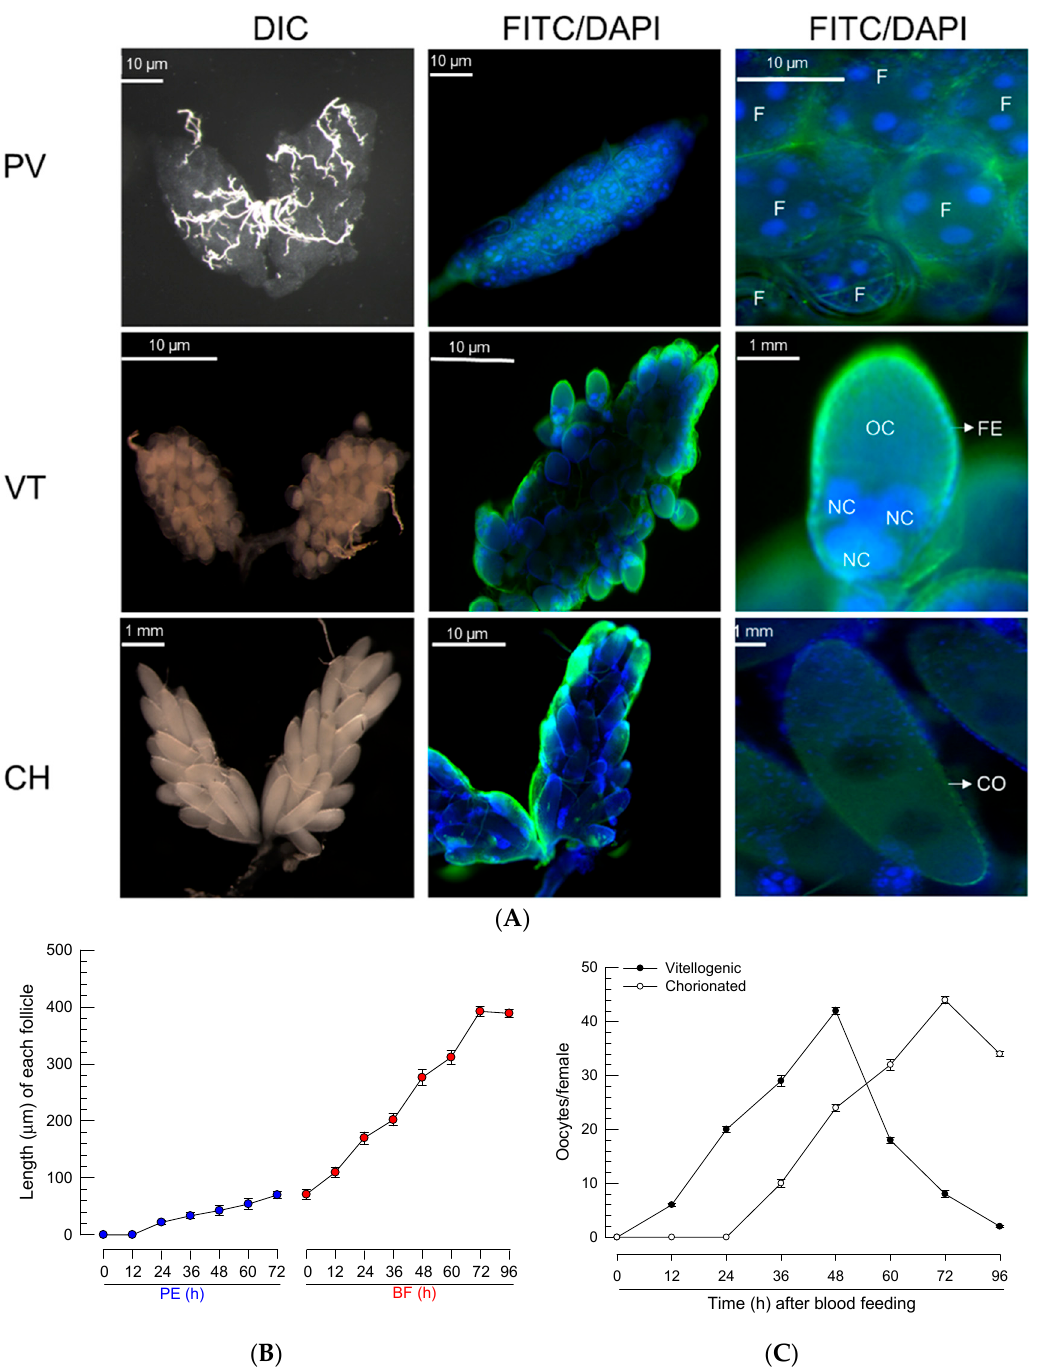
Figure 1. Oocyte development of Ae. albopictus females. ( A ) Three developmental stages of oocytes: previtellogenic (‘PV’), vitellogenic (‘VT’), and chorionated (‘CH’). Ovaries were observed at differ- ential interference contrasts (‘DIC’). Their cells were stained with FITC-tagged phalloidin (green) and DAPI (blue). Follicles (‘F’) were visible at the PV stage. At the VT stage, oocyte (‘OC’) and nurse cell (‘NC’) can be seen to be enclosed with follicular epithelium (‘FE’). At the CH stage, the oocyte can be seen to be chorionated (‘CO’). ( B ) Follicle growth in ovaries post-adult emergence (‘PE’) or post-blood feeding (‘BF’). ( C ) Oocyte development. Total ‘VT’ and ‘CH’ oocytes were counted under a stereomicroscope at the selected time points, up to 96 h post-BF. For each treatment, 10 females were used to analyze follicle growth and oocyte development.